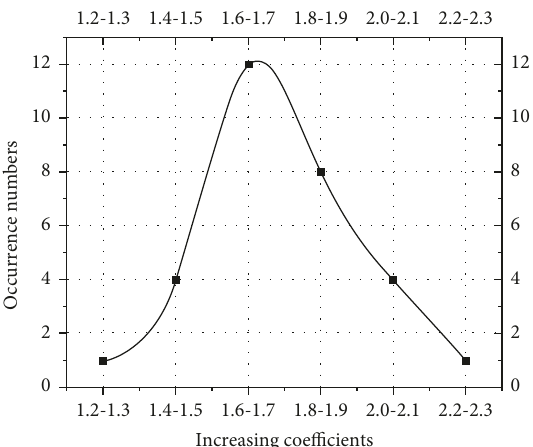
Figure 17: Increasing coefficients of the pole 13’s axial force in the gap interval